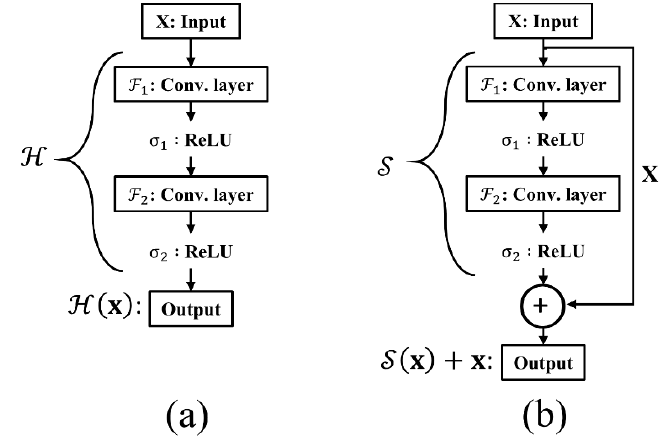
Figure 4. Introduction of residual learning. ( a ) Conventional neural network layers. ( b ) A learning network of residual function S .